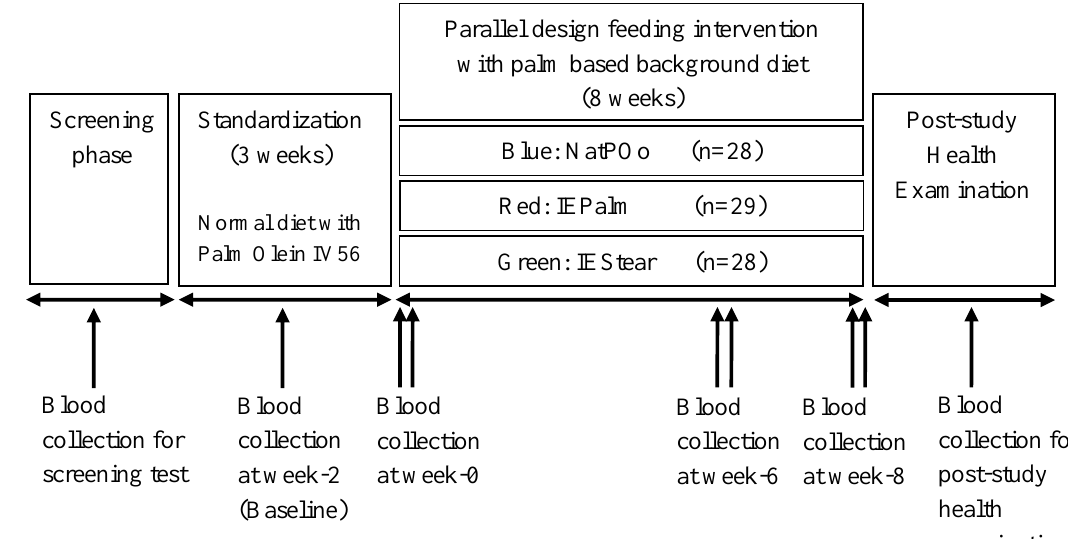
Figure 1. Outline of study design.